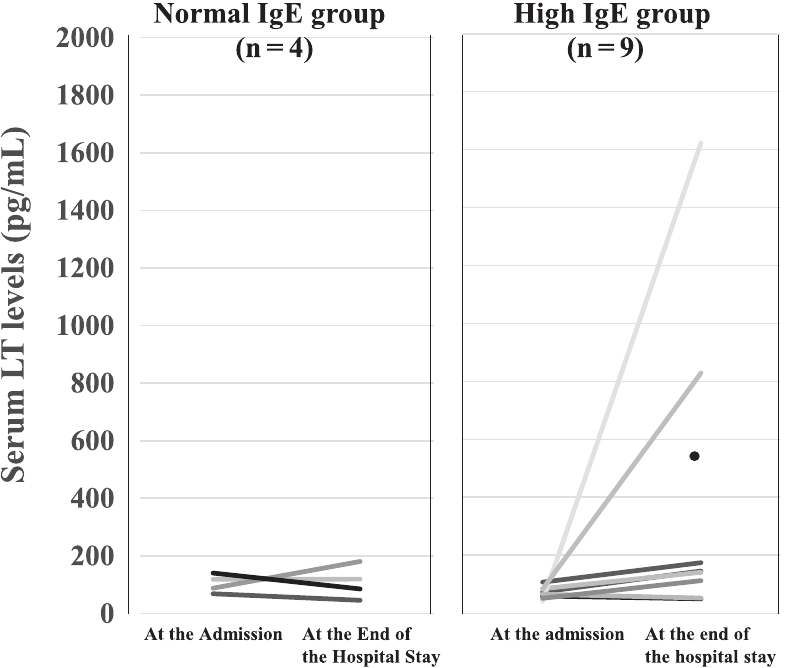
Figure 3. Comparison of the ser u m LT le v els at admission and at the end of the hospital sta y be- t w een the normal I g E g ro u p and hi g h I g E g ro u p. The 13 children w ith RS V lo w er respirator y tract infection w itho u t recei v in g LTRA-treatment w ere di- v ided into t w o g ro u ps, namel y , the normal I g E g ro u p and the hi g h I g E g ro u p, accordin g to the criteria described belo w . The normal ser u m total I g E le v el w as set as <10 IU/mL for infants less than 6 months of a g e, 10-20 IU/mL for infants bet w een 6 and 12 months of a g e, and <50 IU/mL for children bet w een 12 and 24 months of a g e. The ser u m LT le v els increased si g nificantl y onl y in the hi g h I g E g ro u p from admission to the end of the hospital sta y (p = 0.045). LT, le u kotriene; I g E, imm u no g lob u lin E; RS V , respirator y s y nc y tial v ir u s; LTRA, LT receptor anta g